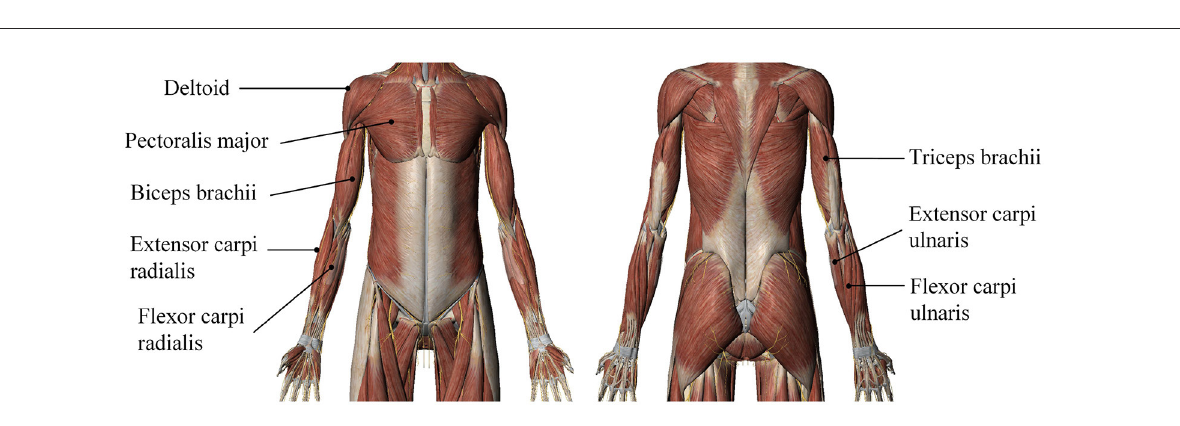
FIGURE3 A map of precise locations of muscles for upper-limb